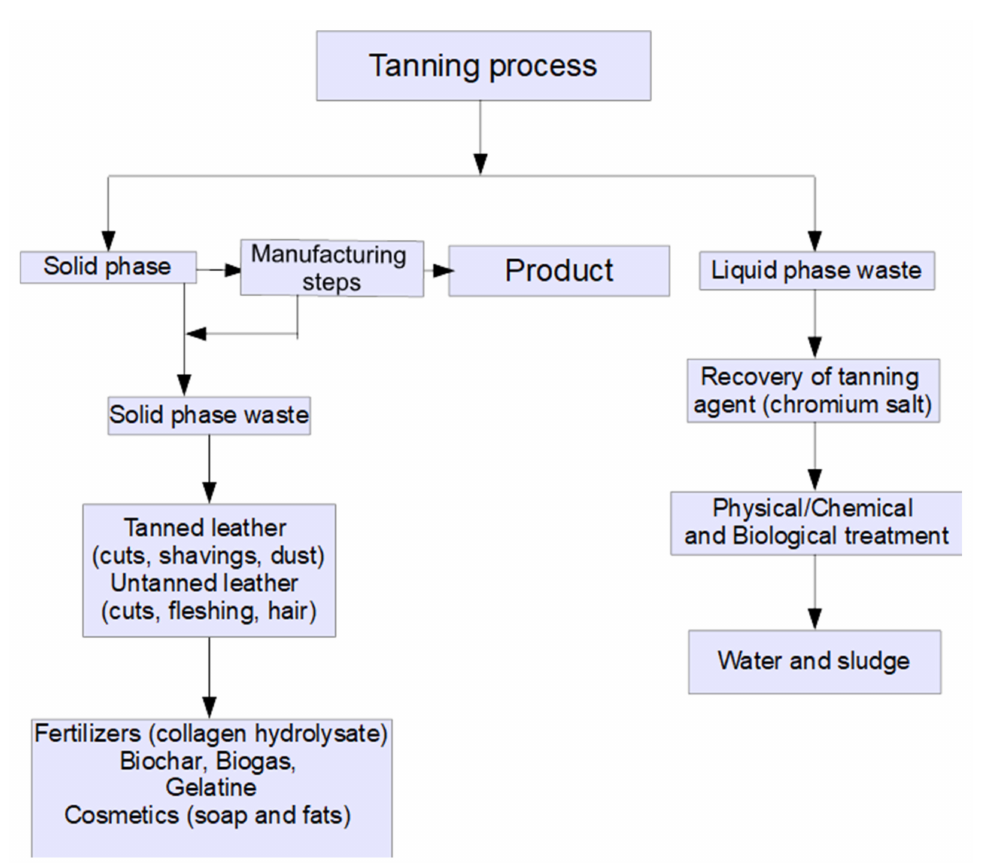
Figure 2. Tanning wastes and alternative ways for wastes